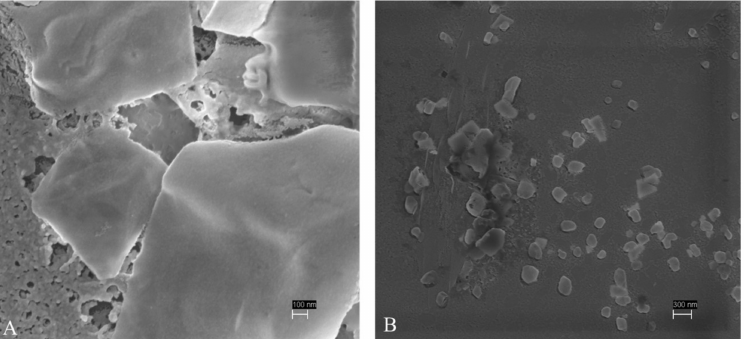
Figure 3. SEM analysis of both ELT-dg ( A ) and ELT-dp ( B ) aqueous suspensions of 100.0 mg/L. These images confirm the presence of some micro- and nanoparticles (size < 1 µ m, based on classification proposed by Hartmann et al. [6] on plastic size) in the selected exposure